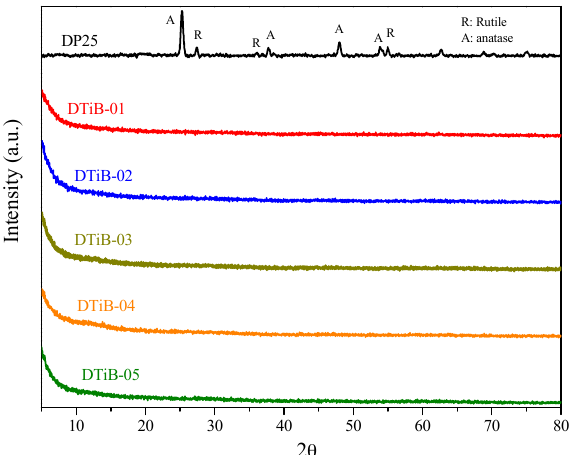
Figure 1. X-ray diffractograms of all the obtained aTiO 2 and commercial DP25 products.